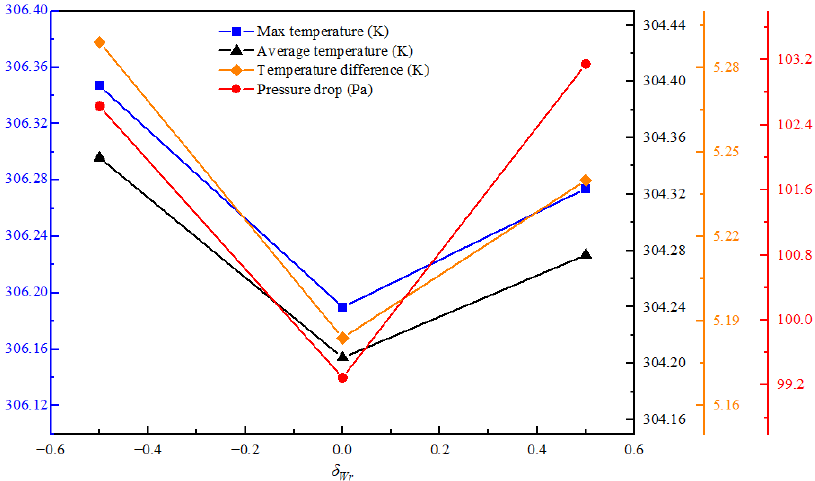
Figure 16. Effect of different pin-fin distributions along the width direction.